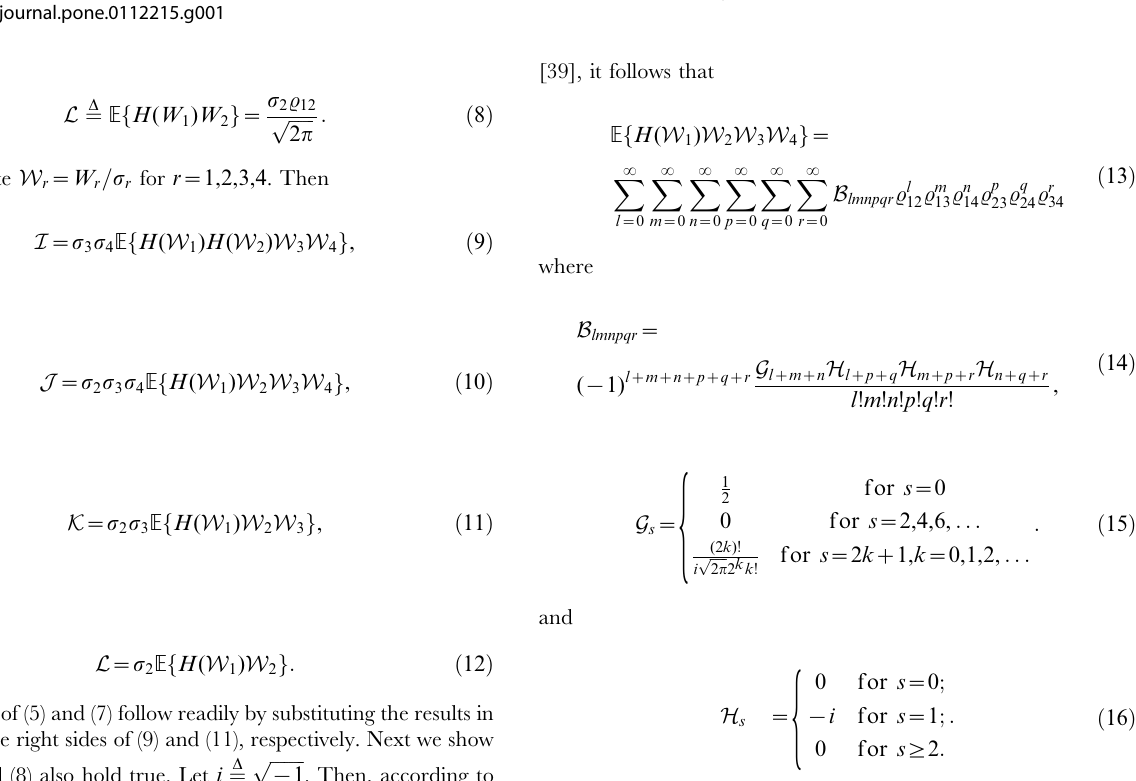
Figure 1. The numerical verification of (21), the expectation of r H in Theorem 1. The number of samples is chose as n ~ 100 . In the vertically up direction, r ’ is decreasing following f 1,0, { 1 g respectively; whereas e corresponds to a increasing trend in the horizontally right direction, following f 0 : 02,0 : 04,0 : 06,0 : 08 g respectively. It shows a good agreement between the simulation result (circles) and the theoretical computation (solid lines) in each subplot. As a reference, the contamination-free version (49) is also posted together (see dashed curves).